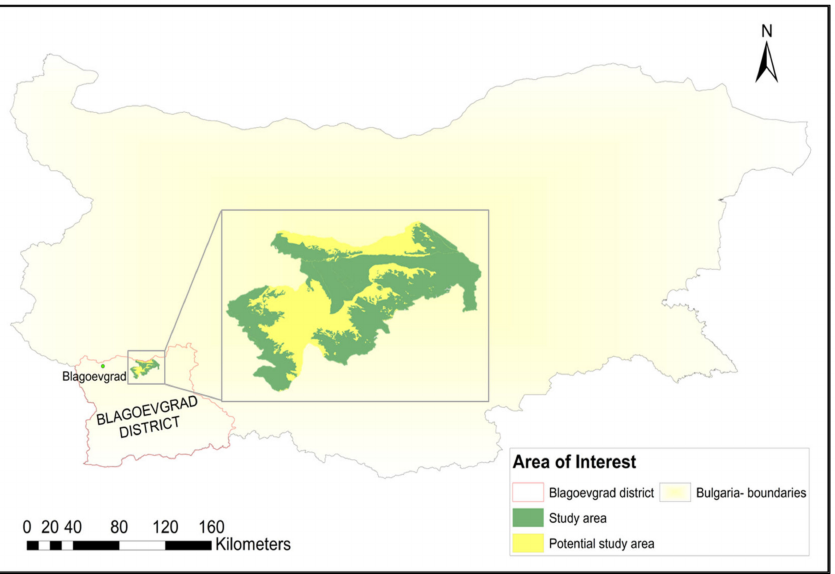
Figure 1. Map of the area of interest: Potential study area (yellow) and parts of it studied in the current paper